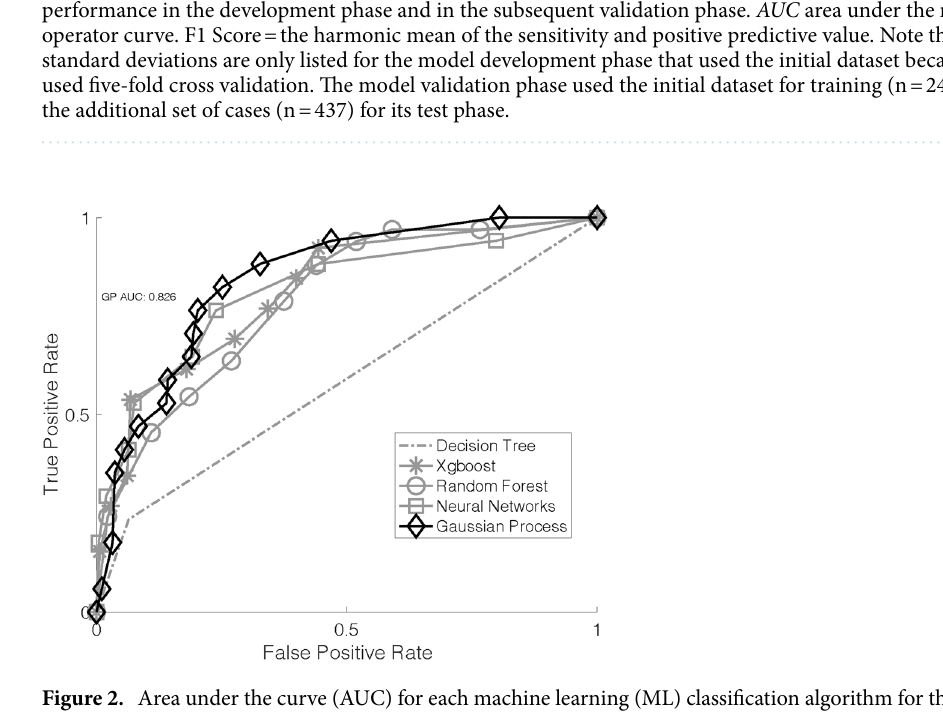
Figure 2. Area under the curve (AUC) for each machine learning (ML) classification algorithm for the development phase. Here, we used only the initial dataset (n = 2410) with five-fold crossvalidation to reduce overfitting. Gaussian Process (GP) demonstrated the greatest AUC and overall